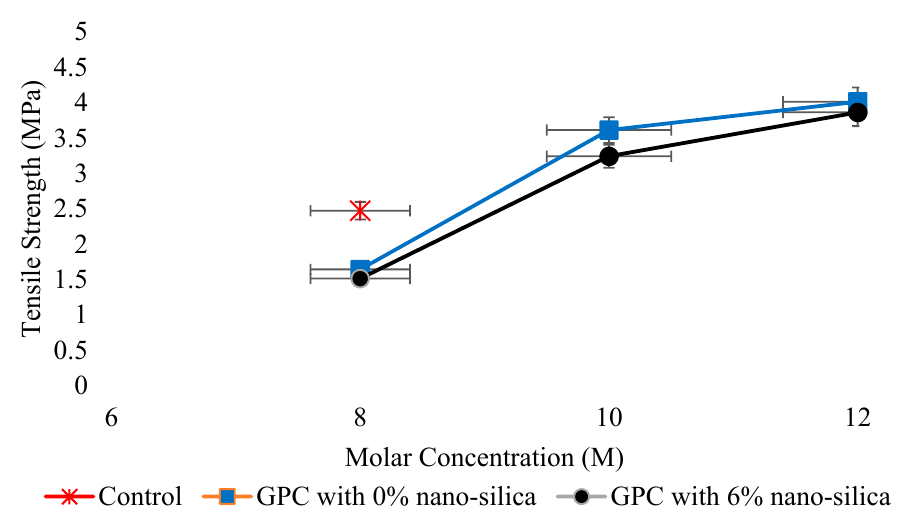
Figure 16. Relation of tensile strength with molar concentration, modified from [140]; Elsevier, 2014. As far as the flexural strength of geopolymer mortar is concerned, Elyamany et al. [116], found that it increases with the enhancement of compressive strength (Figure 17). The figure summarizes the relationship between the square root of compressive strength and flexural strength of di ff erent mixes.